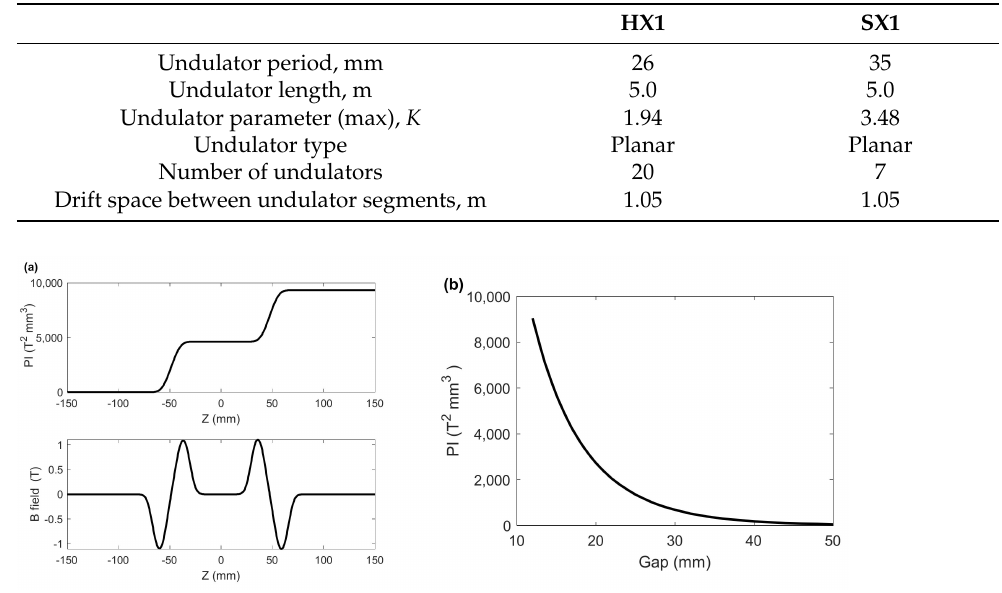
Figure 3. ( a ) Field profile of a phase-shifter at the minimum gap and ( b ) phase integral as a function of the phase-shifter gap